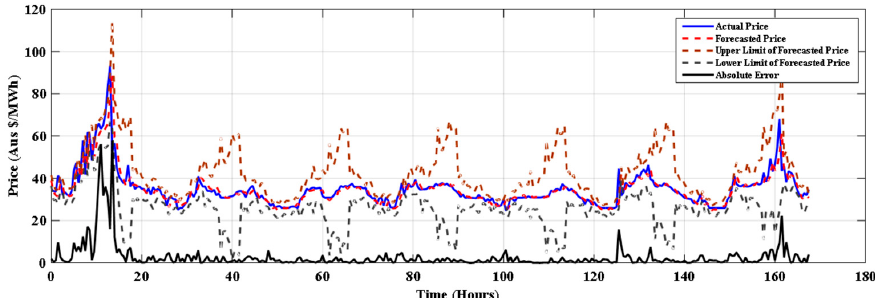
Figure 5. Forecasting for 22–28 January 2016 in summer with SMO regression+ FS.